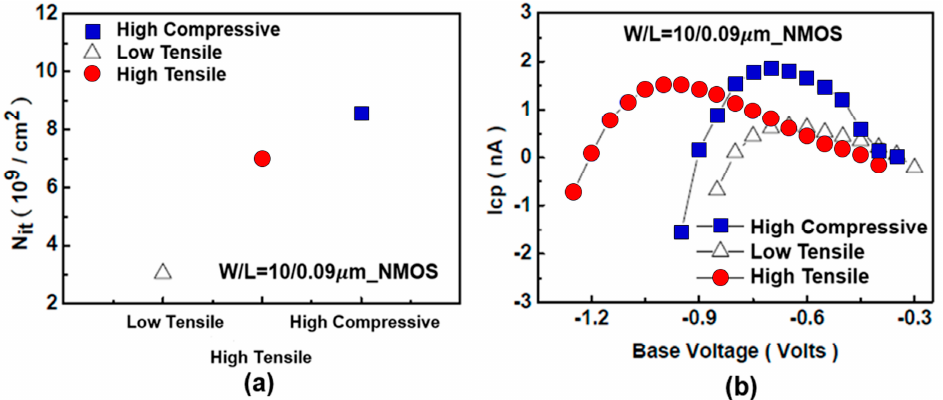
Figure 17. Influence of layer strain on defects in the charge pumping experiment. ( a ) Icp currents and ( b ) charge density at the interface (converted from the Icp currents), in NMOS devices subjected to different stresses [13].